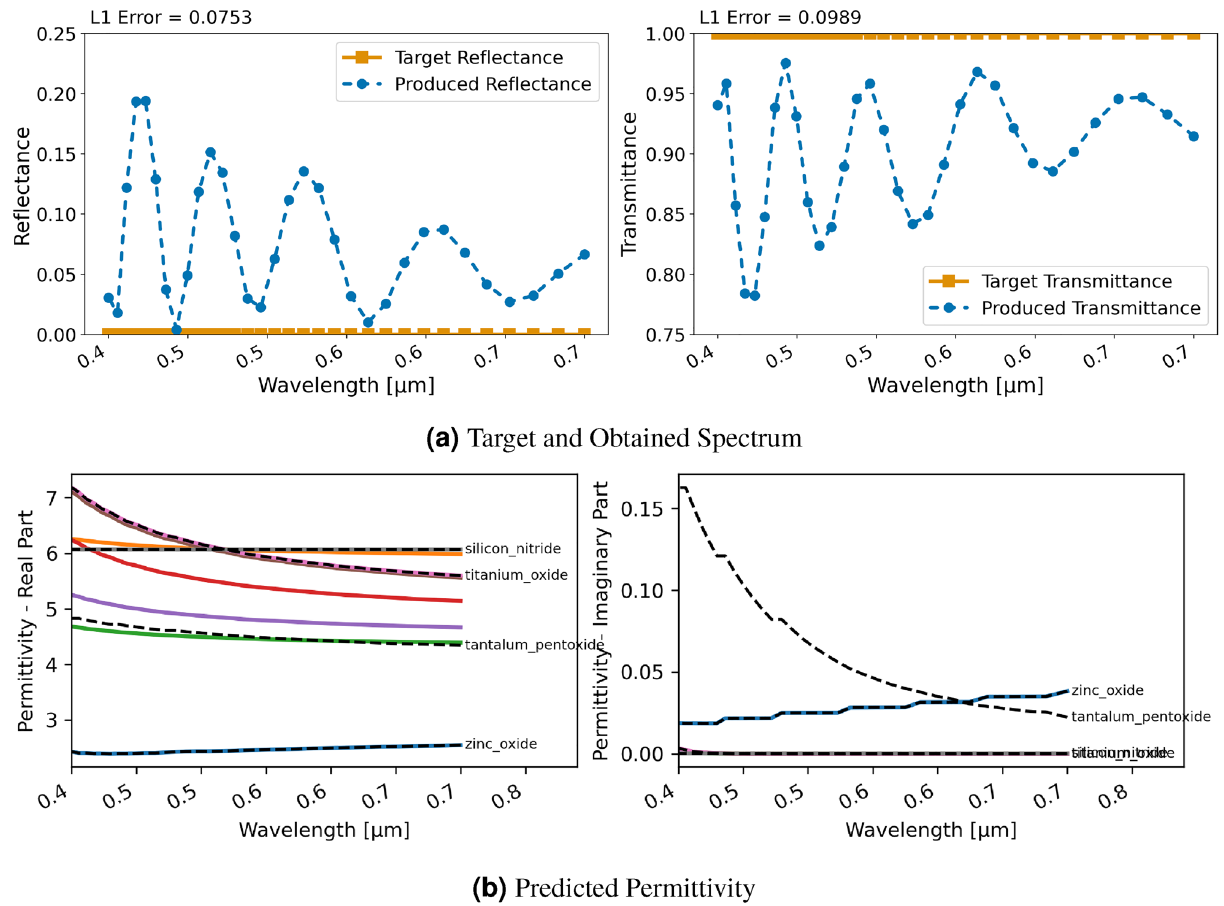
Figure 11. Inversion results for designing an anti-reflection coating with an eight layer stack using RCWA and classification; ( a ) displays target and produced spectra, ( b ) shows the utilized permittivity for each layer and closest material in NIDN